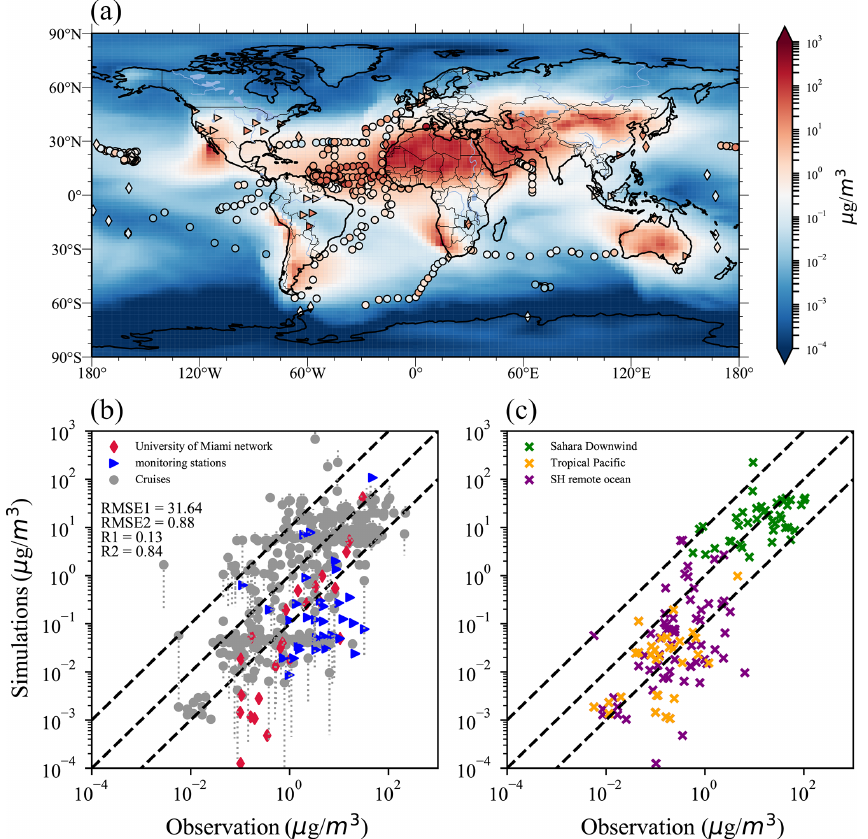
Figure 3. (a) Simulated global dust surface concentrations (µgm − 3 ) averaged from 2014 to 2019 from CESM1/CARMA shown with the filled contour. The summarized dust surface concentration datasets from Huneeus et al. (2011) are indicated by markers of different shapes. Compiled observations, including those from long-term observational sites and cruise data reported in Mahowald et al. (2009), are indicated by triangles and circles, respectively. Measurements from the University of Miami network (Prospero et al., 1989; Prospero, 1996; Arimoto et al., 1995) from 1981 to 1998 are indicated with diamonds. (b) Comparison of the simulated dust concentrations by CESM1/CARMA with the compiled observational dataset from Mahowald et al. (2009) and the University of Miami network. Gray circles and blue triangles represent selected data from the Mahowald et al. (2009) short-term cruises and long-term observations, respectively. Red diamonds represent the University of Miami network measurements. “R1” and “RMSE1” represent the correlation coefficient ( R ) and the root mean square error (RMSE) between simulations and measurements from Mahowald et al. (2009), respectively. In the meantime, “R2” and “RMSE2” represent the University of Miami dust data. The gray dotted line indicates the simulated error bar extracted from the simulated daily concentration, following the method in Mahowald et al. (2008). (c) Same as panel (b) but the North African downwind area and the tropical Pacific basin and SH remote ocean are represented as green, orange, and purple stars, respectively. The 1 : 1, 1 : 10, and 10 : 1 relationships between the simulated and observed dust concentrations are indicated by the black dashed